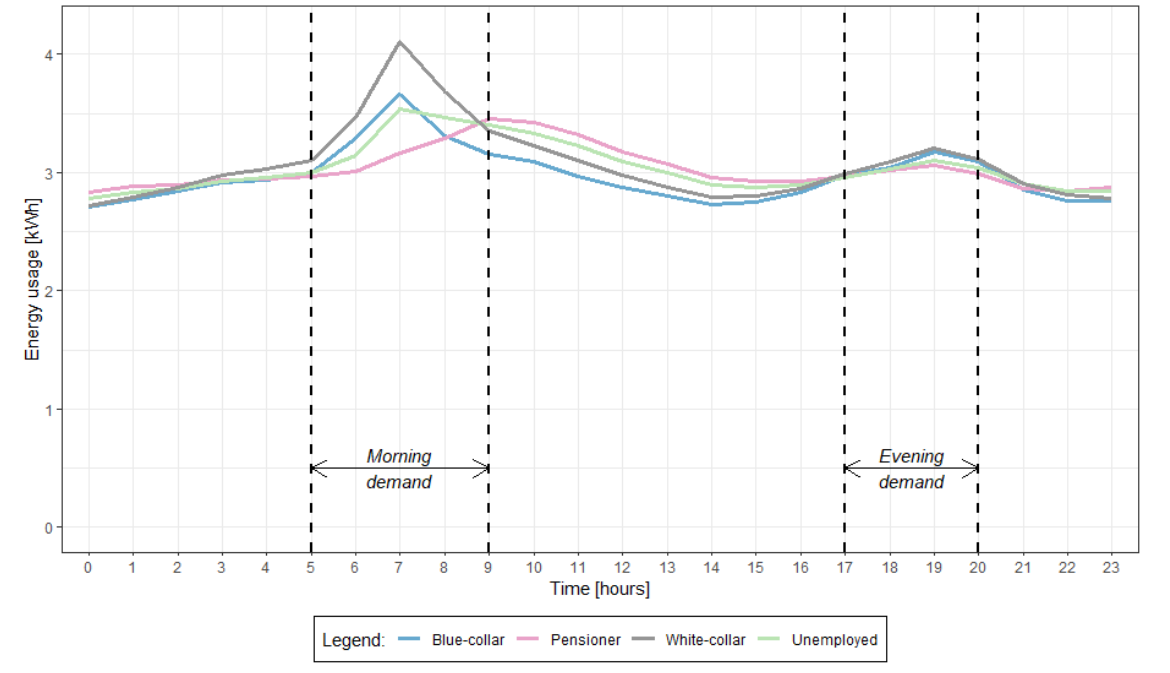
Figure 4. Heat usage profile for an average day for occupational groups based on average hourly consumption. N = 2,005,091; n =